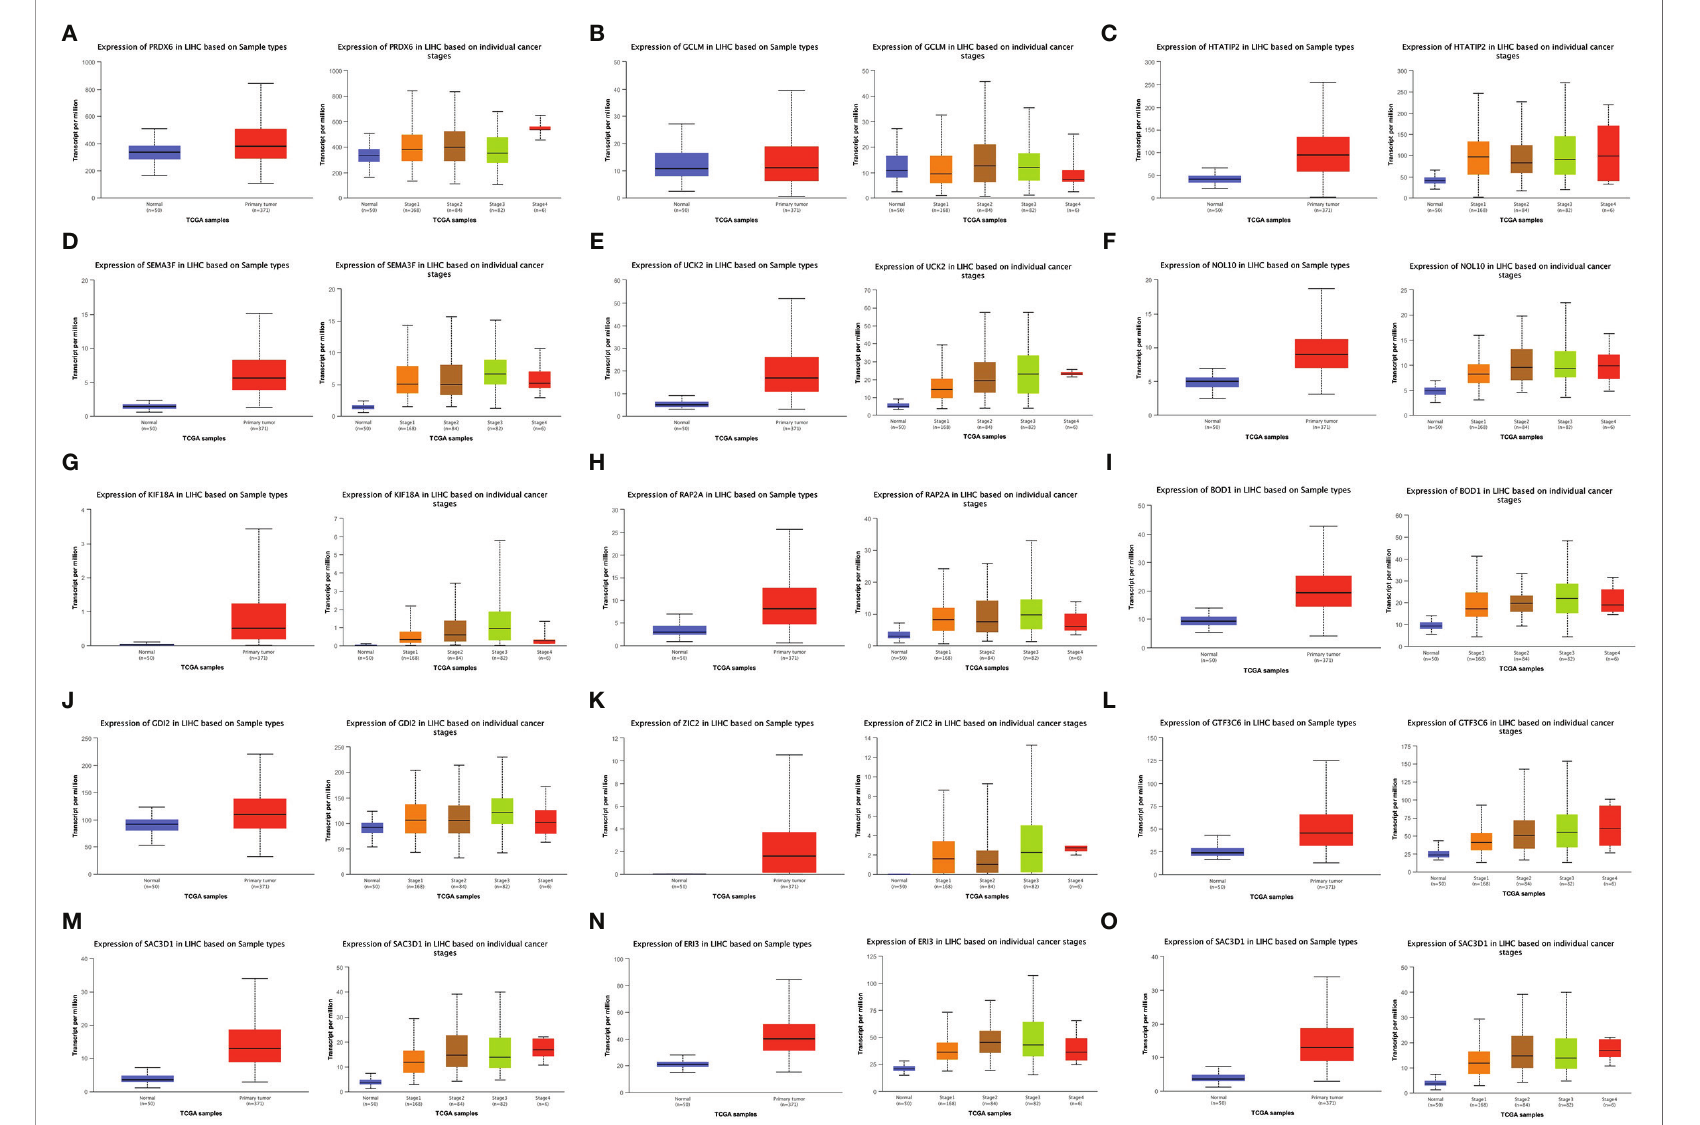
FIGURE 5 | Expression of 15 Signature genes in LIHC in cancer/normal and different stages. [ (A) PRDX6; (B) GCLM; (C) HTATIP2; (D) SEMA3F; (E) UCK2; (F) NOL10; (G) KIF18A; (H) RAP2A; (I) BOD1; (J) GDI2; (K) ZIC2; (L) GTF3C6; (M) SLC1A5; (N) ERI3; (O)